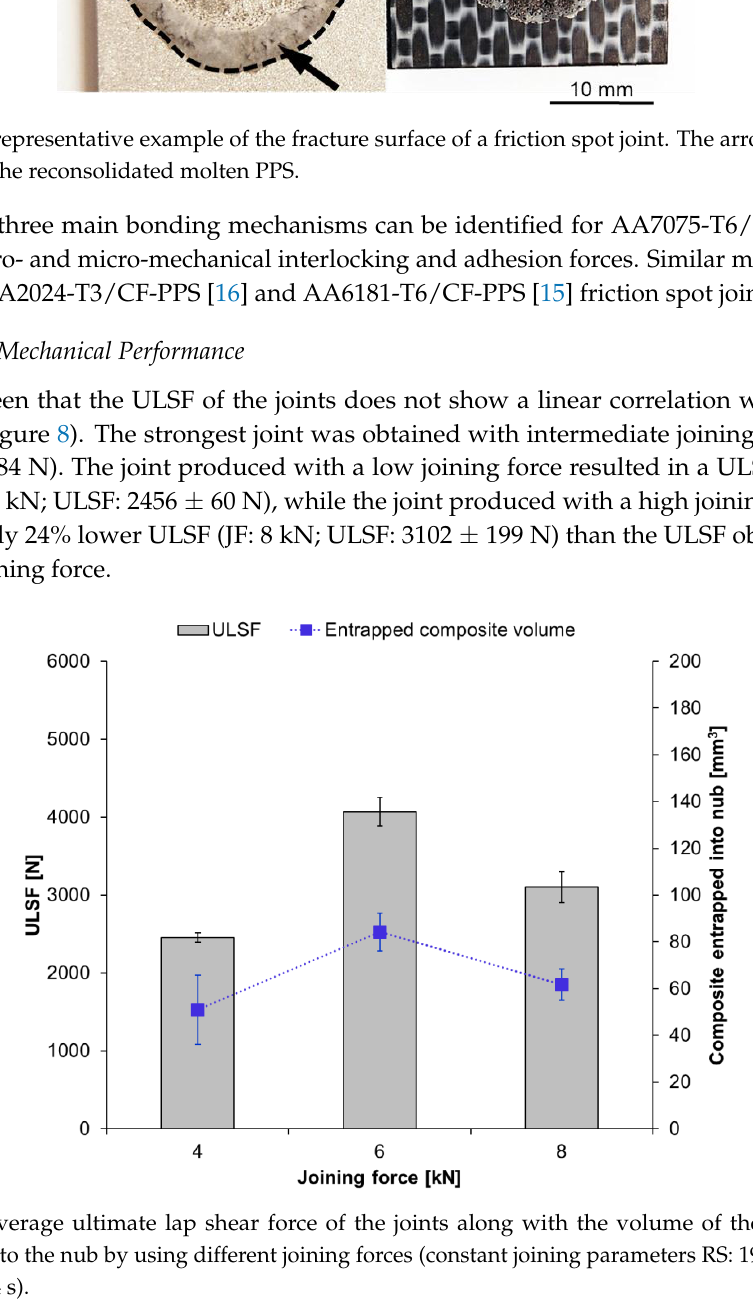
Figure 8. Average ultimate lap shear force of the joints along with the volume of the composite entrapped into the nub by using different joining forces (constant joining parameters RS: 1900 rpm, PD: 0.8 mm, JT: 4 s).